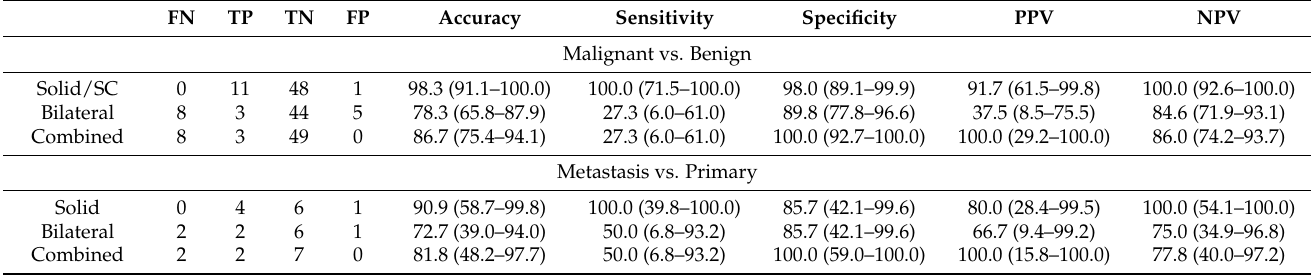
Table 3. Diagnostic accuracy of whole-body computed tomography for ovarian